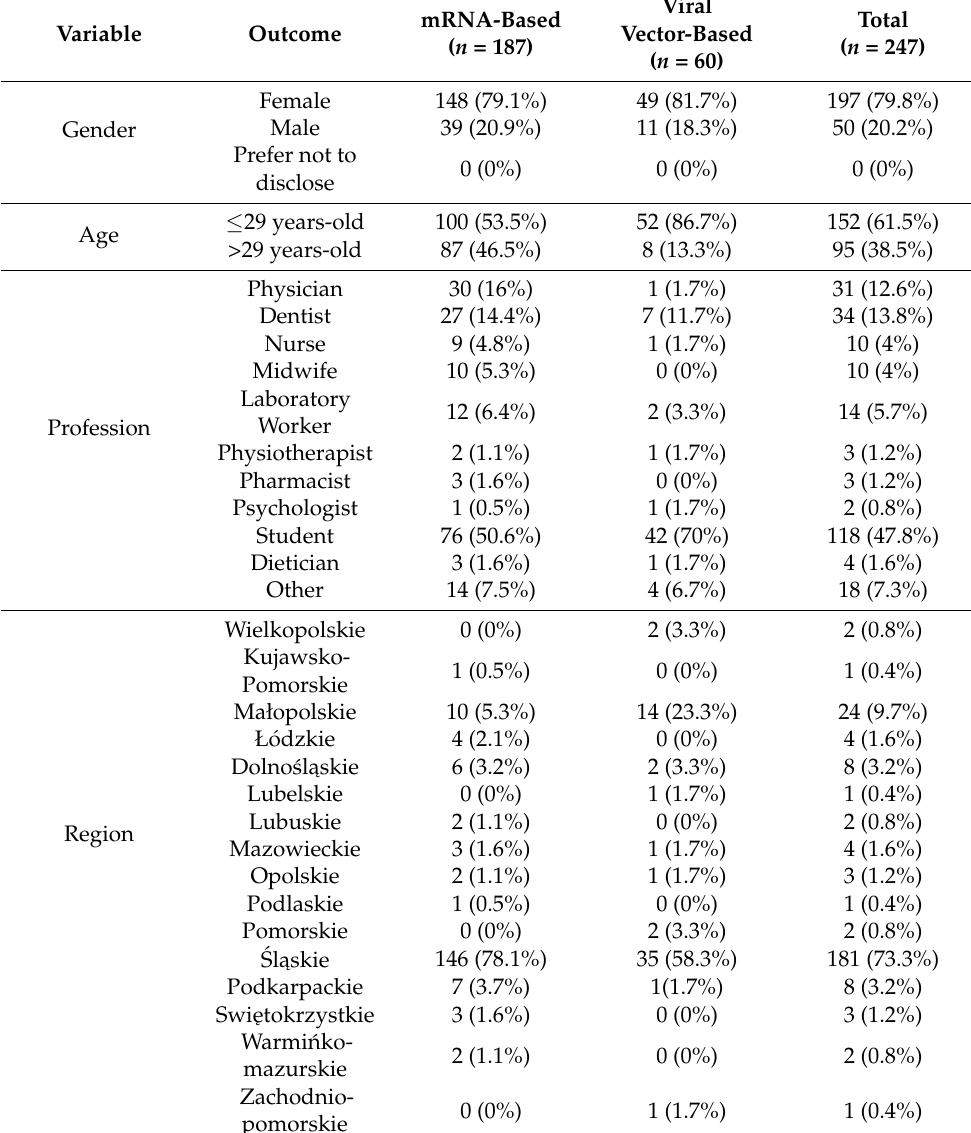
Table 1. Demographic characteristics of the surveyed Polish healthcare